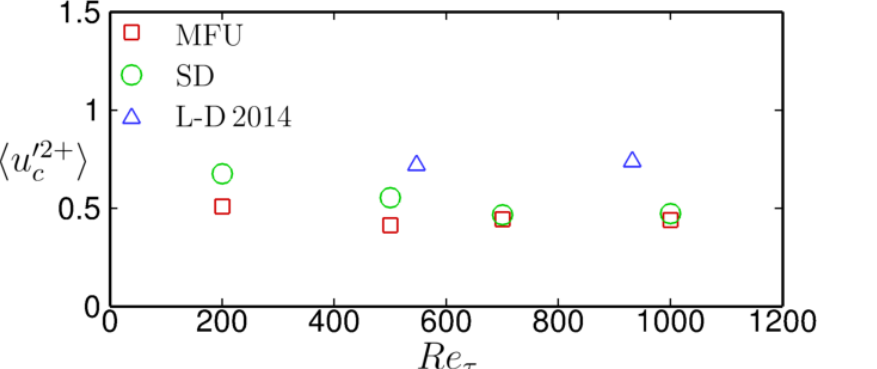
Figure 4. Mean velocity profiles for minimal flow units (MFU) and sub-domains (SD) for various Reynolds numbers along with the viscous sublayer and logarithmic law. Inset: Log-law diagnostic function Ξ + . The dashed horizontal line is 1/ κ , where κ is the von Kármán constant and κ = 0.384.